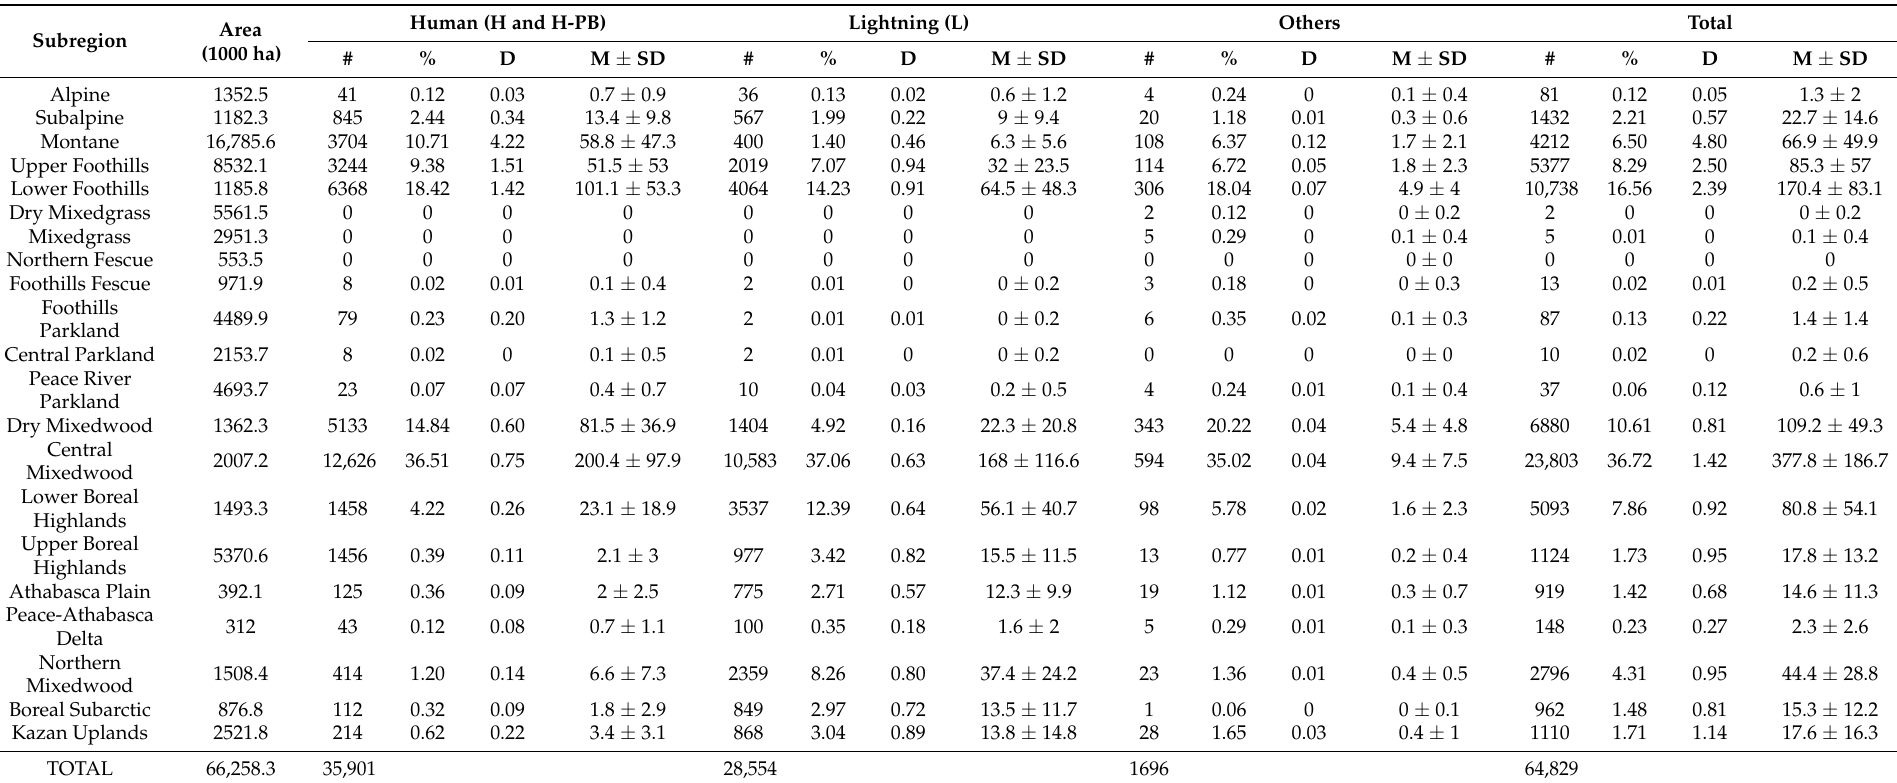
Table 1. Total number (#), percent (%), density (D, per 1000 hectares—ha), and mean ± standard deviation (M ± SD) of forest fire occurrences by cause of initial ignition in the subregions of Alberta during 1959–2021. Here, human category includes both human (H) and human-prescribed burn (H-PB)